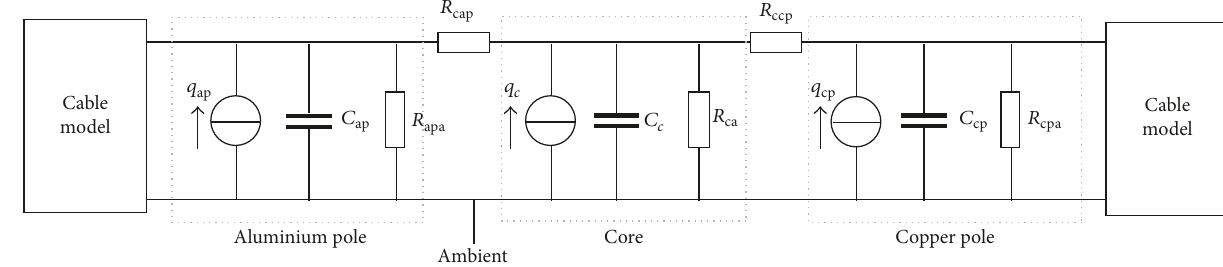
Figure 3: Thermal RC-network model of